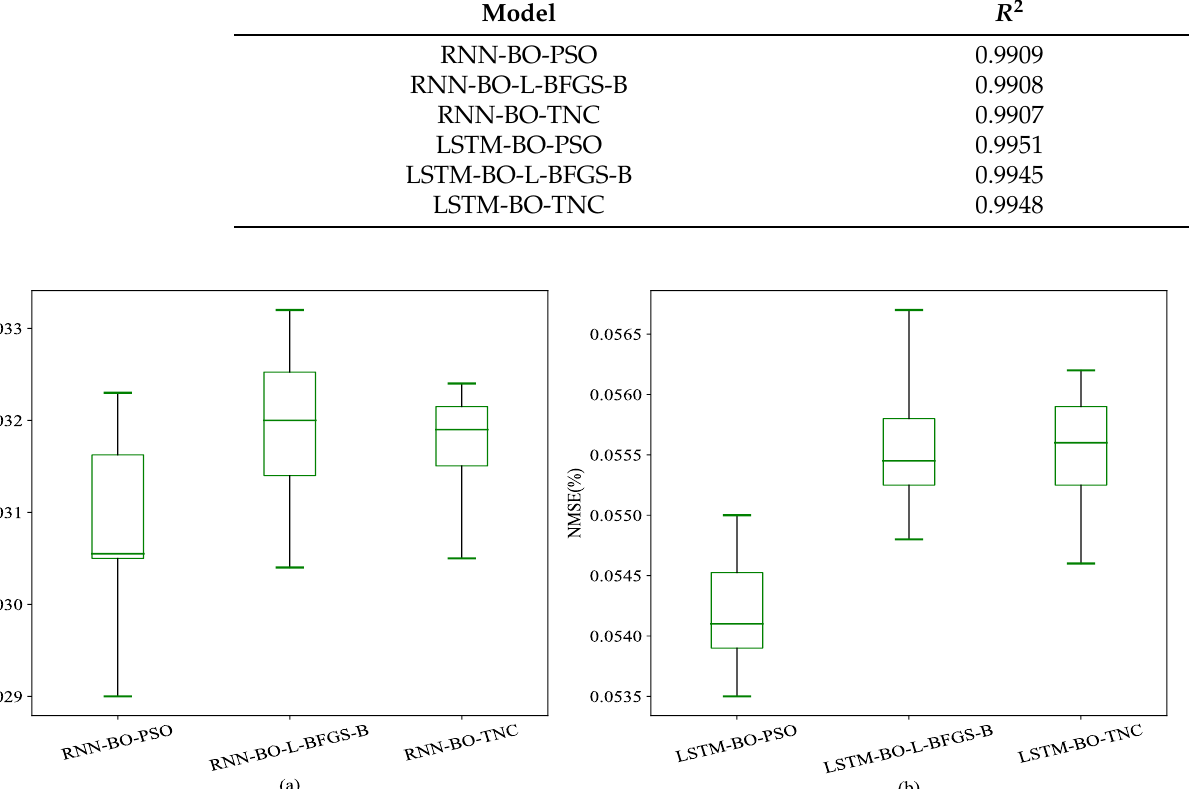
Figure 5. NMSE box line diagram for different models. ( a ) Value of NMSE of RNN models for each method. ( b ) Value of NMSE of LSTM models for each method.